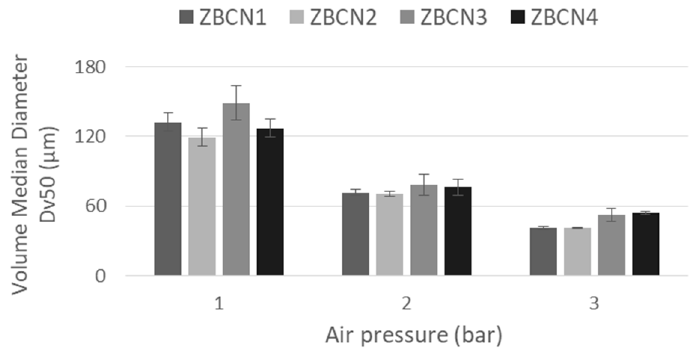
Figure 4. Dependence between the median diameter and air pressure.